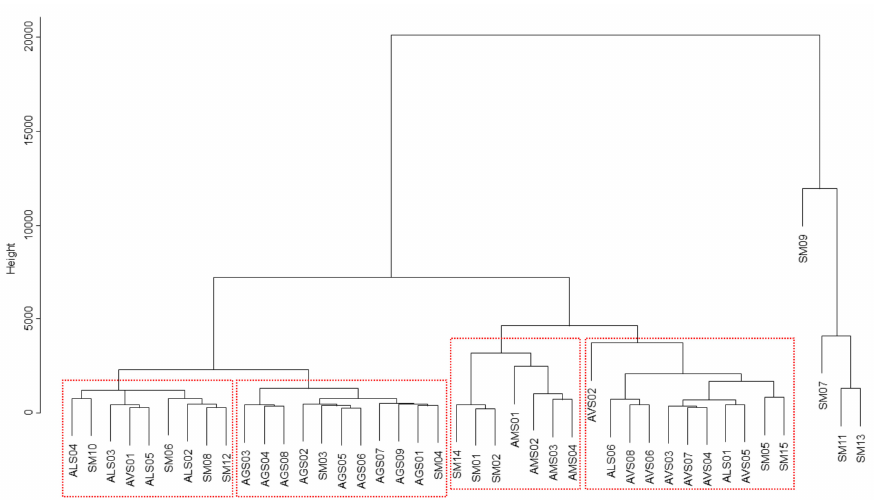
Figure 4. Dendrogram of Amomi Fructus samples from the hierarchical clustering